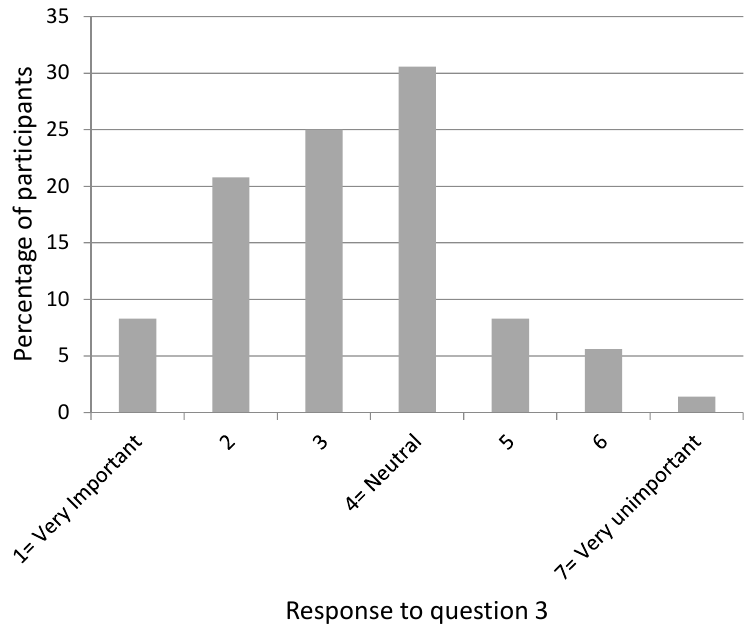
Figure 2. Participants’ response to Question 3: “How important are your own values (beliefs, priorities & preferences) in helping edentulous patients make treatment decisions?”